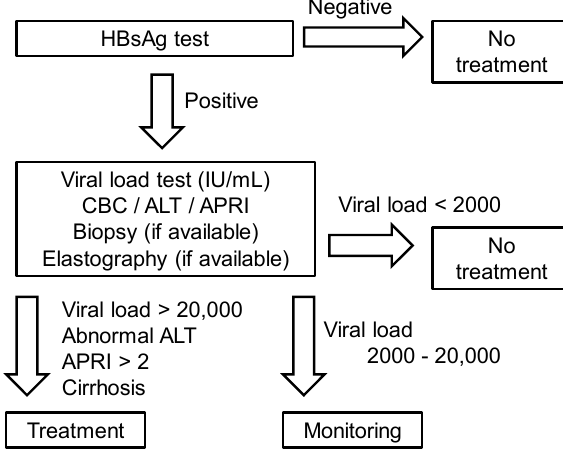
Figure 3. Proposed algorithm for treatment of chronic hepatitis B virus (HBV) infection for resource-limited countries based on the viral loads. First, clinicians conduct laboratory tests of the HbsAg in blood, diagnose HBV infection, and test the viral loads, alanine aminotransferase